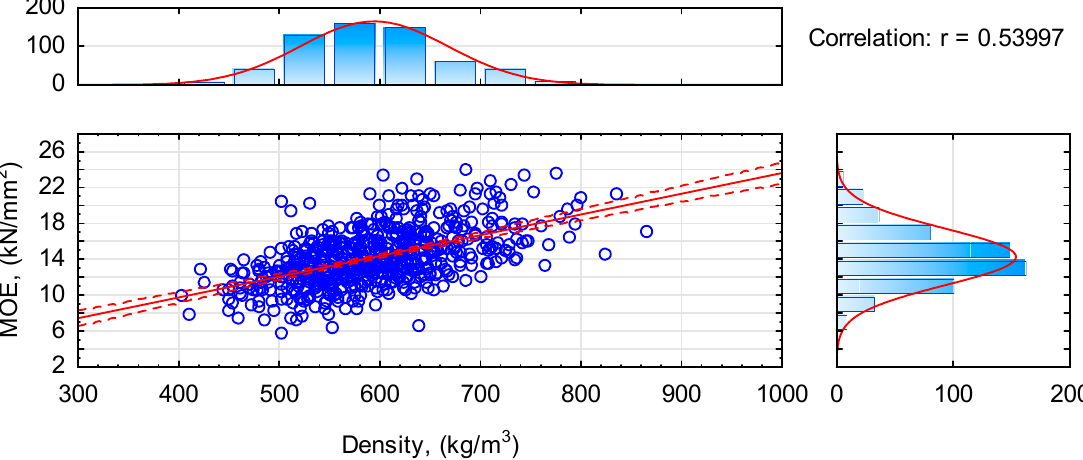
Figure 5. The effect of density on the modulus of elasticity determined in a 4-point bending test.